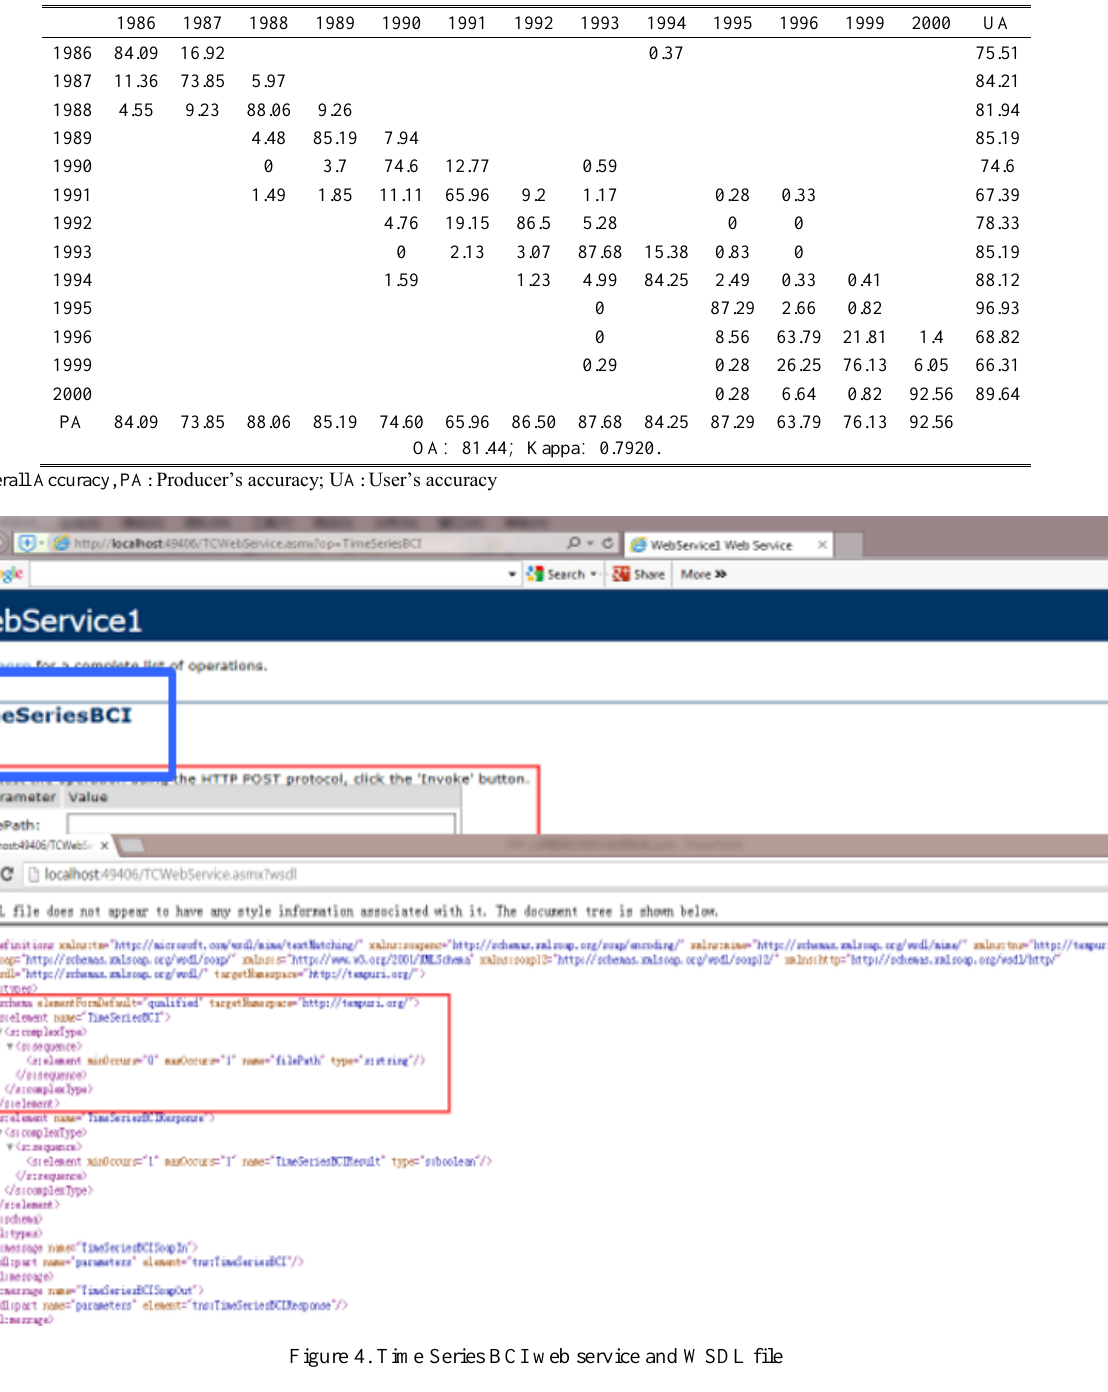
Table 1. accuracies of annual urban built-up change area result (%)